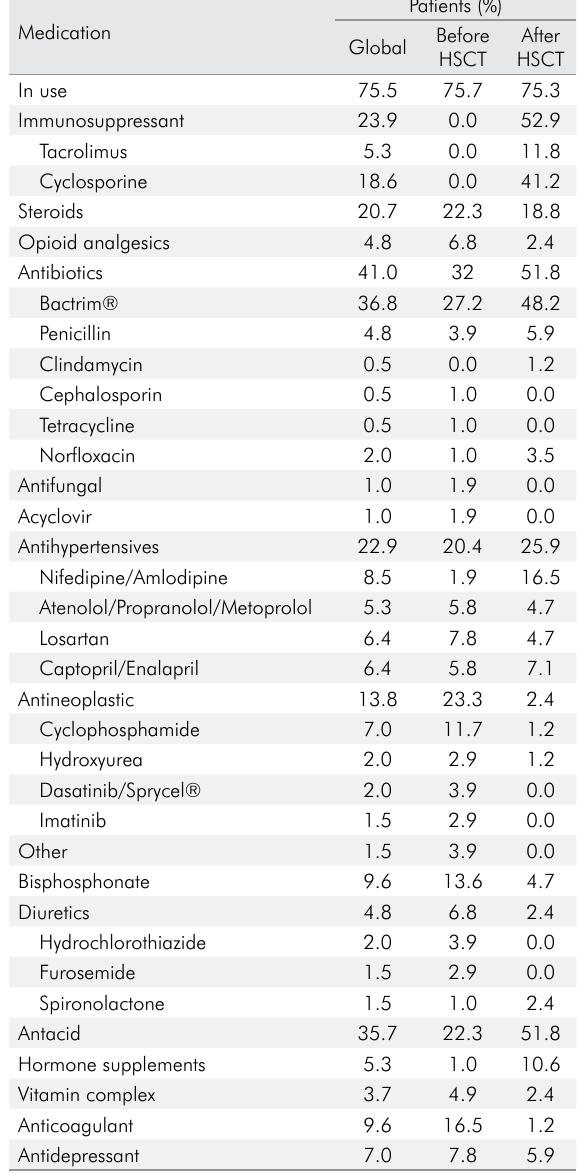
Table 3. Percentages of medications used by individuals enrolled in the Program of Dental Care for Transplanted Patients, FO-UFMG.